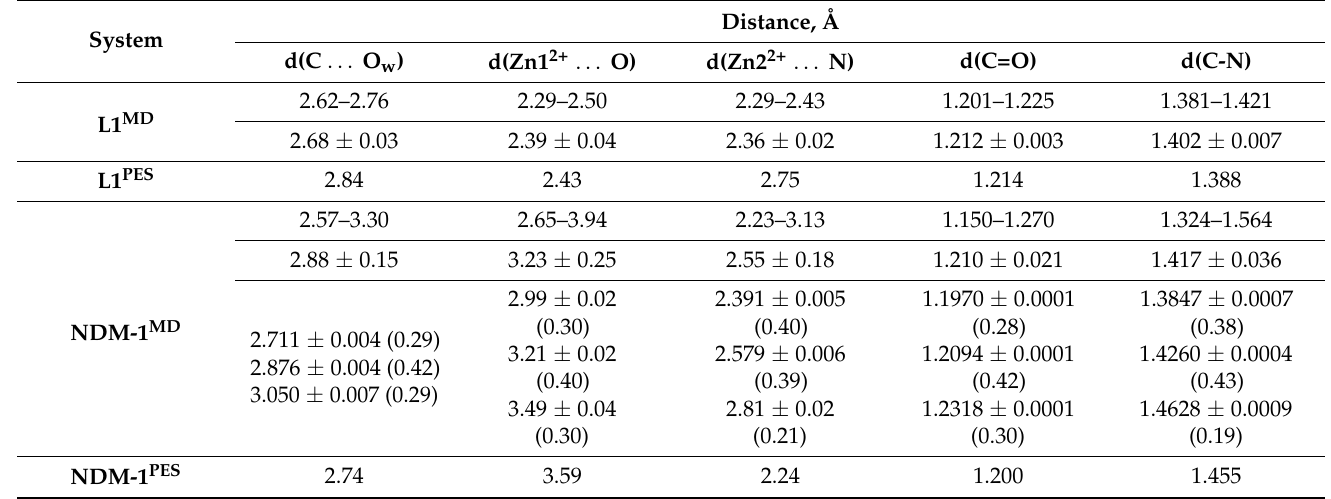
Table 1. Key interatomic distances obtained in the QM/MM MD simulations (with “MD” superscript) and at the minima on the potential energy surfaces corresponding to the ES complexes [8] (with “PES” superscript) for the L1-ES and the NDM-1-ES. In the rows with the QM/MM MD results the first line is for the range of corresponding distance and the second for the average value and standard deviation. The third line in the NDM-1 MD row corresponds to the decomposition of the distance distributions into three states (weight of each state is in